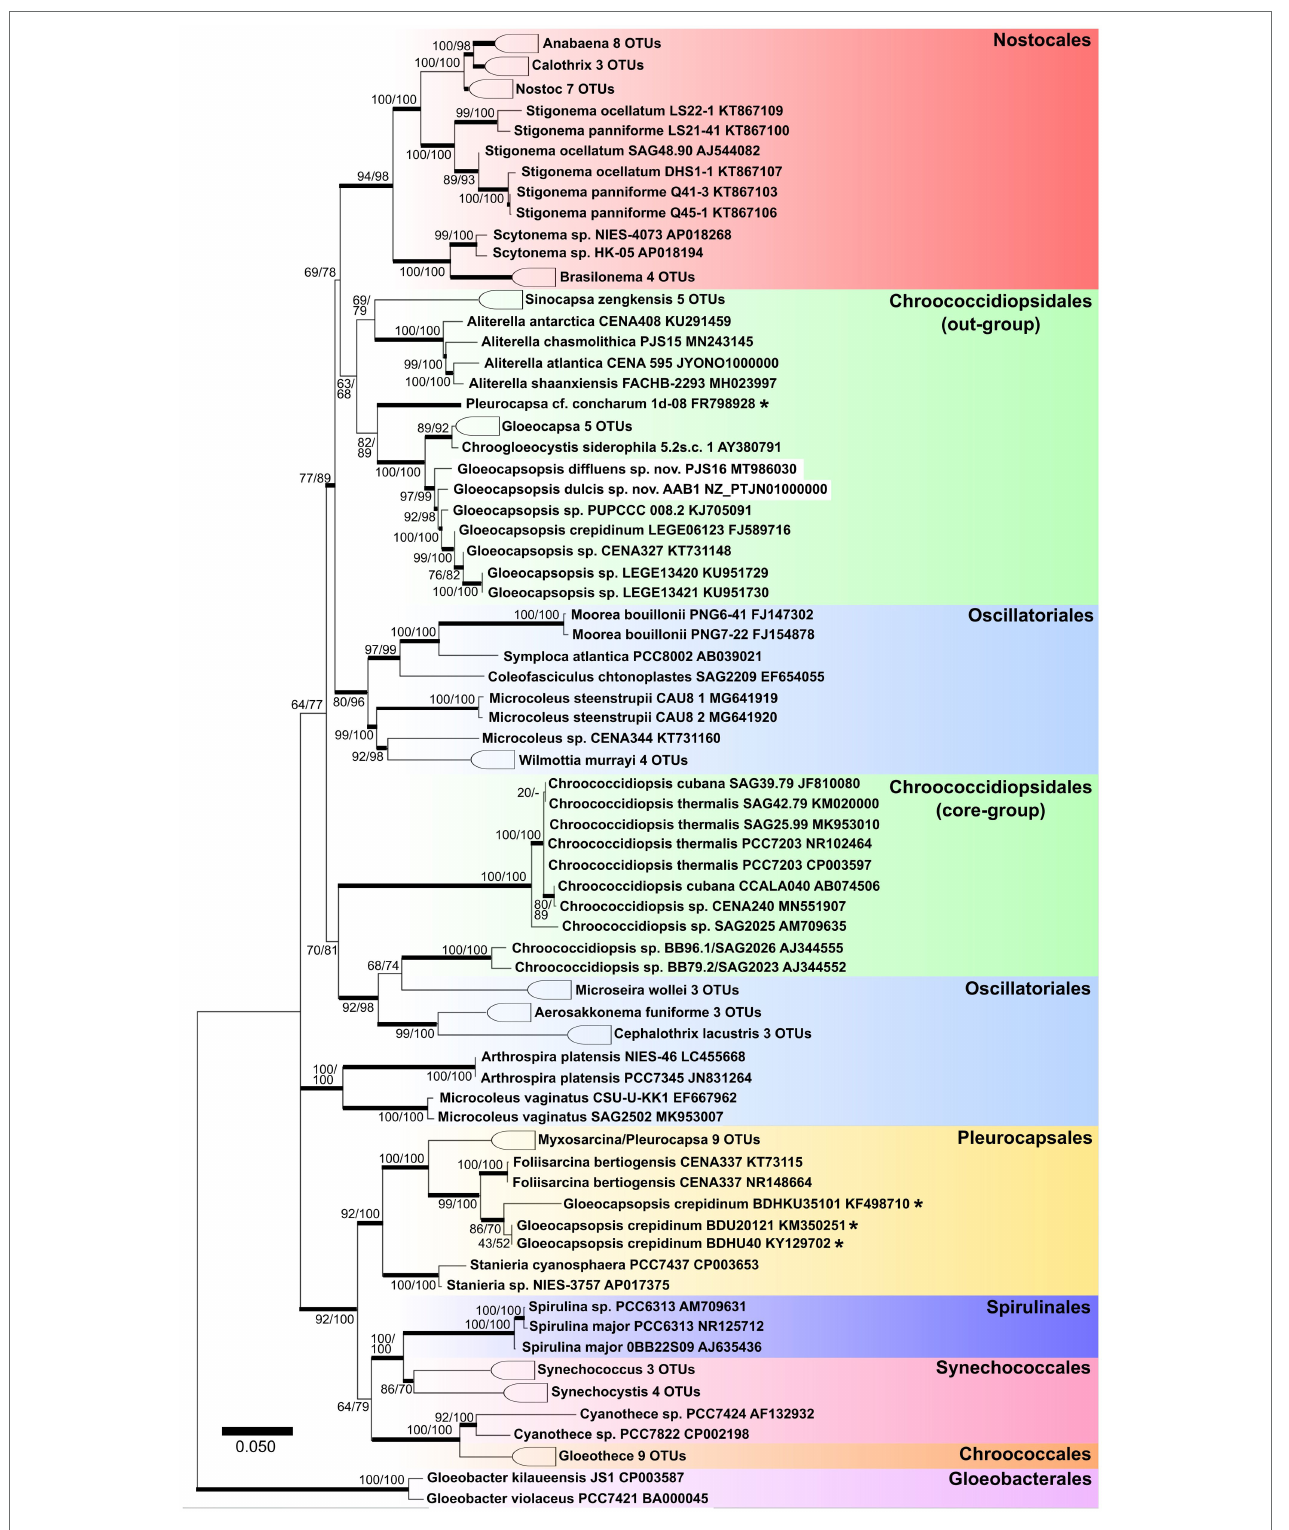
FIGURE 2 | Maximum likelihood tree obtained from 121 aligned 16S rRNA gene sequences of all known orders of cyanobacteria. Numbers on the nodes represent ML and Bayesian bootstrap values, respectively, (1,000 replicates). Bold horizontal lines show lineages supported by at least 75% of bootstrap values. Asterisks identify sequences with ambiguous taxonomic